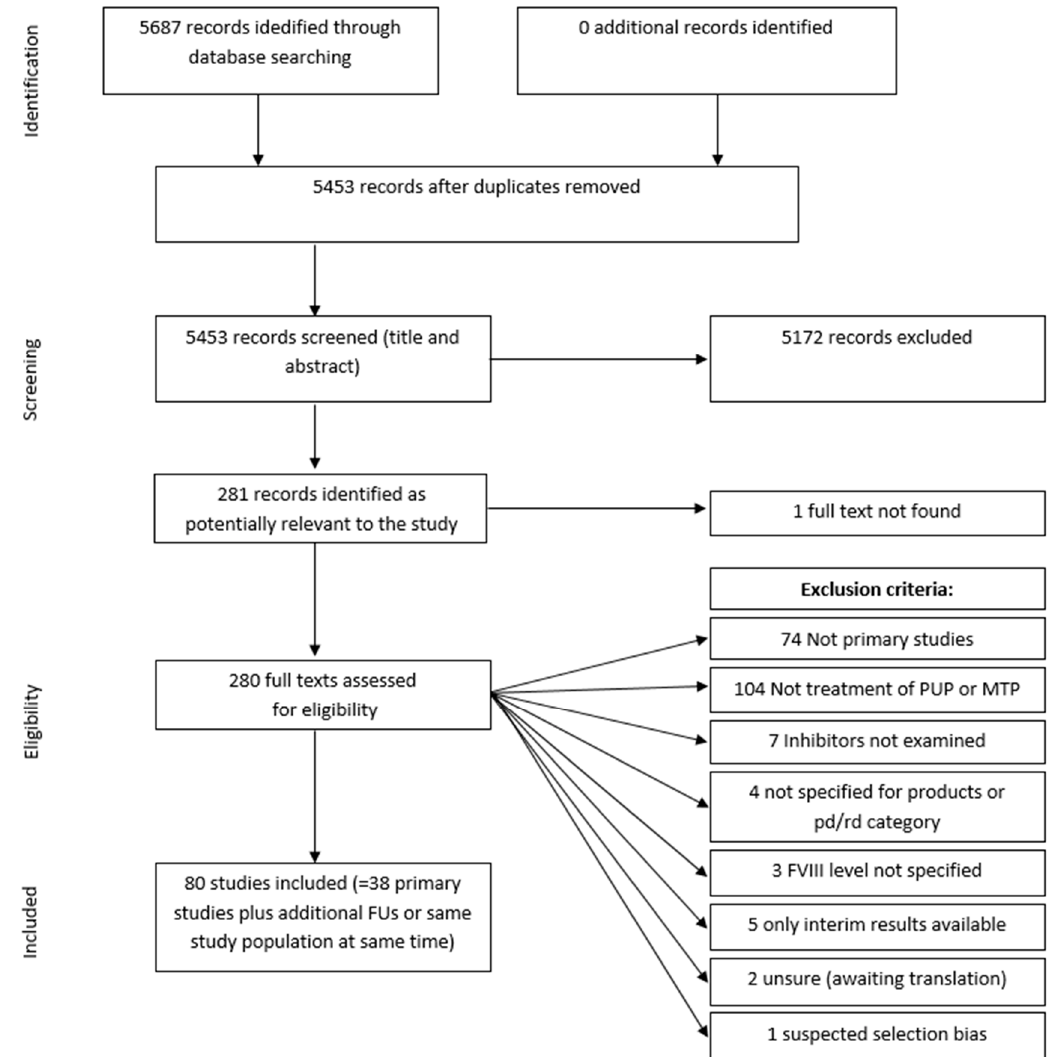
Figure 2. Flow of information from screening and inclusion process.